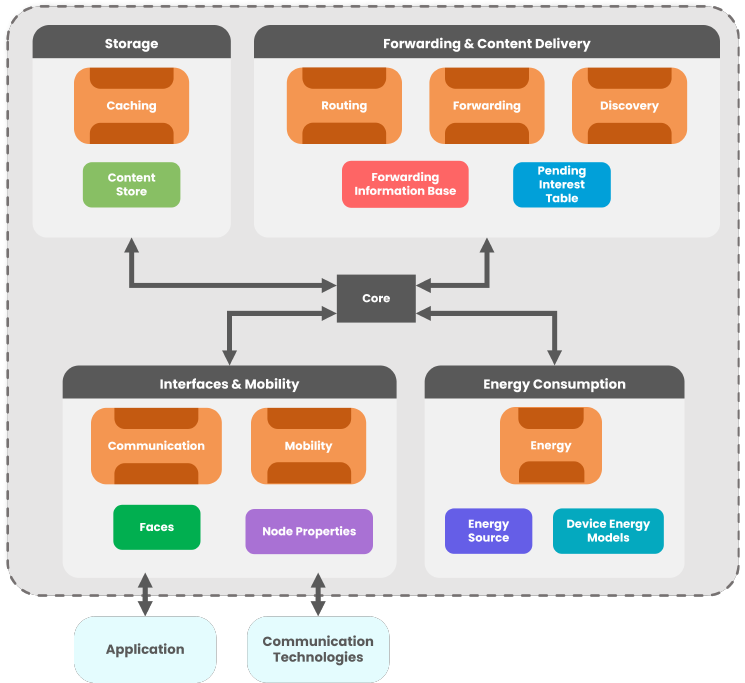
Figure 4. Energy-efficient wireless NDN-based